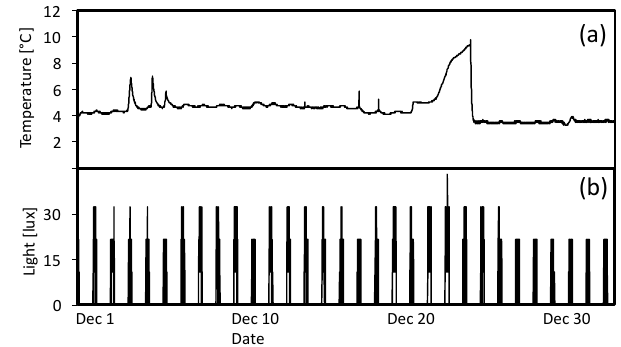
Figure 8. (a) Temperature ( ◦ C) and (b) light (lux) during December in high-light portion of 7 ◦ C tank.